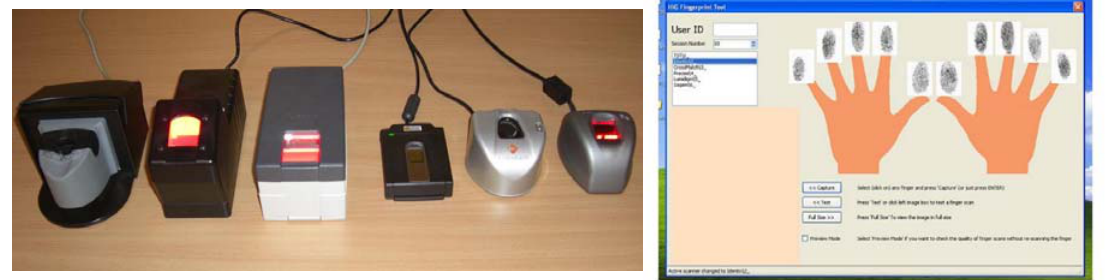
Figure 2. Left : fingerprint sensors used to collect data for GUC100 (from left to right): TST BiRD 3, L-1 DFR 2100, Cross Match L SCAN 100, Precise 250 MC, Lumidigm V 100 and Sagem MorphoSmart; Right : interface of the data collection